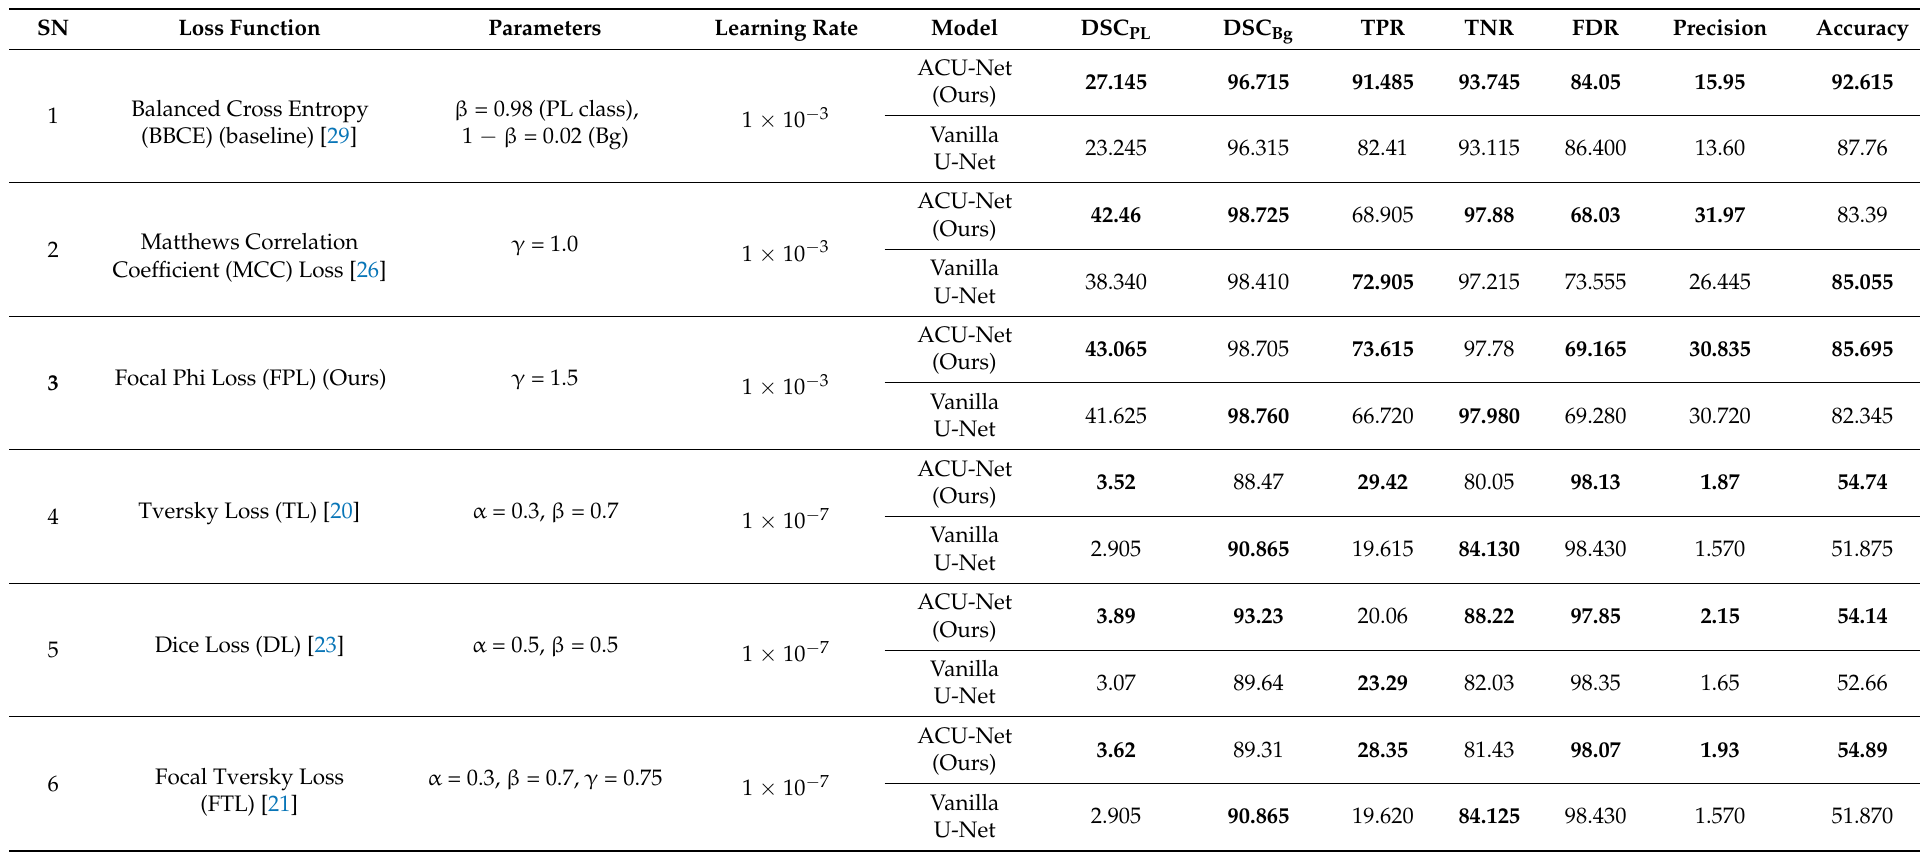
Table 6. Experimental results comparison of the proposed ACU-Net and vanilla U-Net model with various loss functions on PLDU with 120